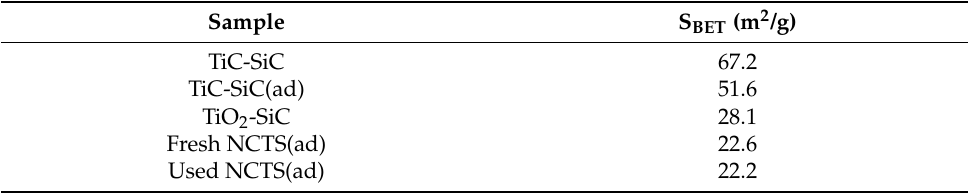
Table 3. BET results of support, fresh and used 10Ce-Ni/TiO 2